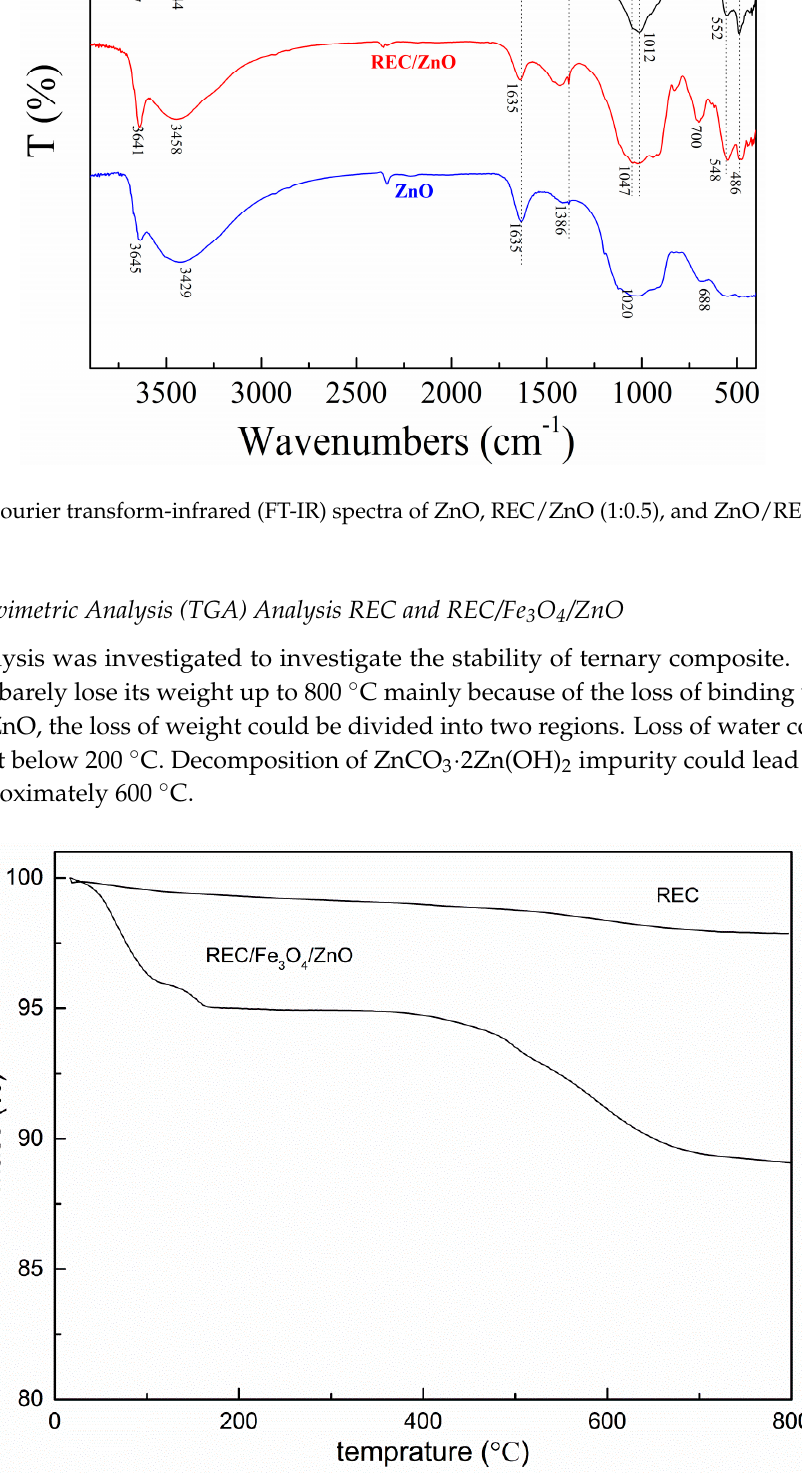
Figure 4. TGA of REC and REC/Fe 3 O 4 /ZnO (1:0.3:0.5).